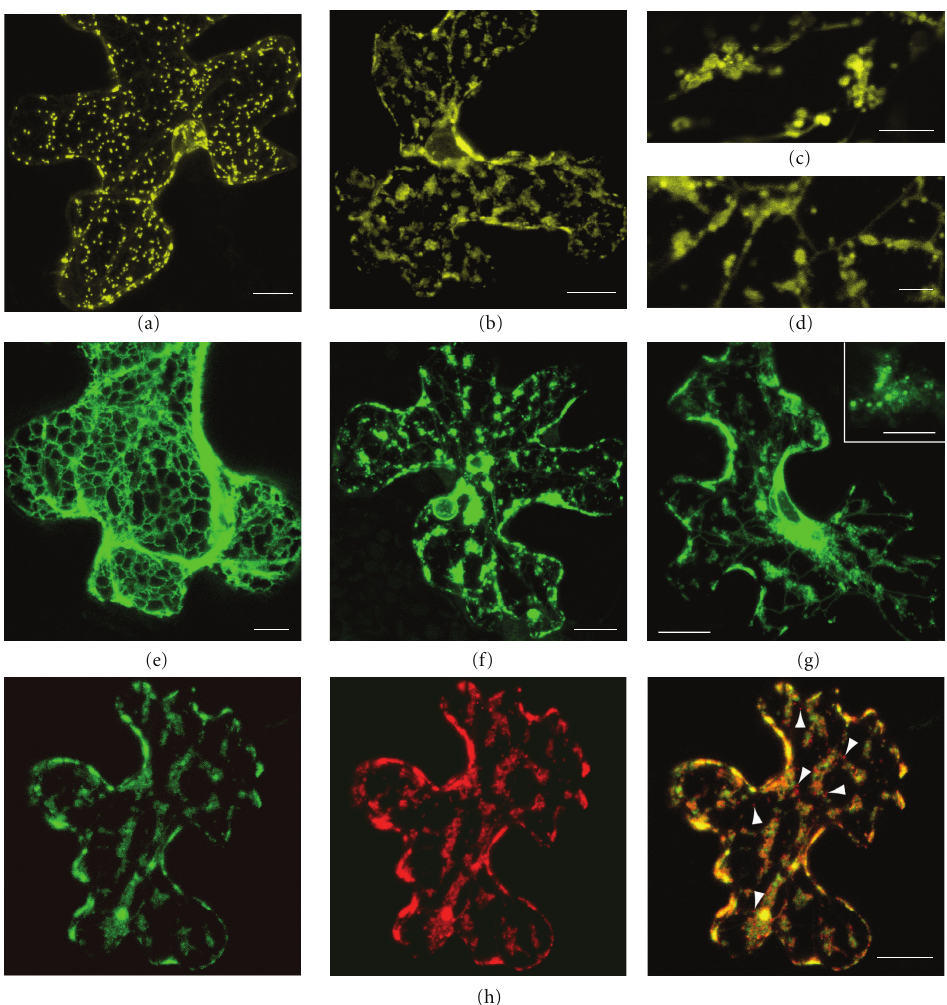
Figure 1: Co-expression of non-fused 18 K with the ER and Golgi markers in bombarded epidermal cells of N. benthamiana leaves. (a) ST-YFP. (b)–(d) ST-YFP + 18K. (e) m-GFP5-ER. (f) and (g) m-GFP5-ER + 18K. (h) ST-YFP + m-GFP5-ER + 18 K. In (h), GFP signal is shown in the left panel, YFP signal—in the middle panels, and the merged image—in the right panel. All images except (b) and (c) and the insert in (g) are reconstructed by superposition of series of confocal optical sections. Arrowheads in (h) point to round structures of 0.5–1.0 μ m in diameter presumably representing Golgi stacks remained una ff ected upon the 18K expression. Scale bar: 20 μ m in (a), (b), (f), (g), and (h); 10 μ m in (e); 4 μ m in (c) and (d); 3 μ m in the insert in